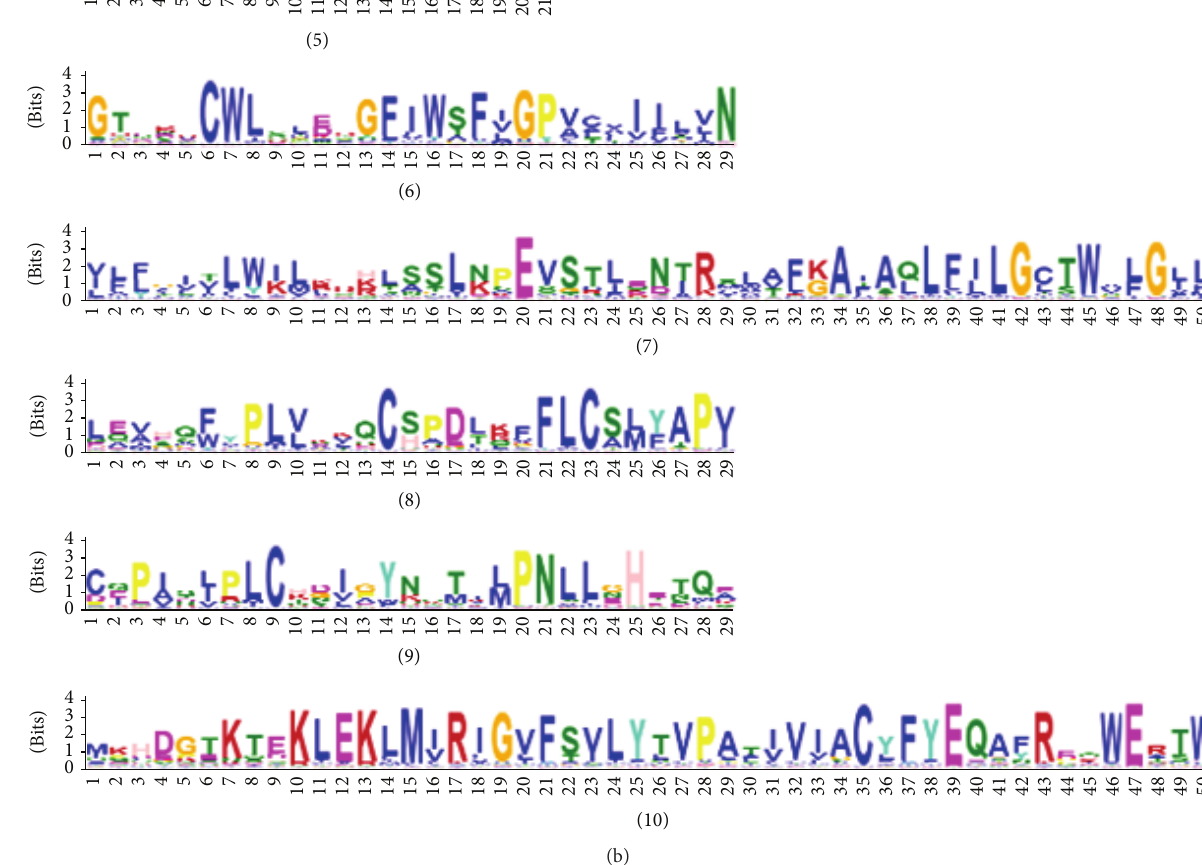
Figure 1: The discovered motifs of human GPCRs from the MEME system (for details see Table 6). (a) MEME run showing combined block diagram for top ten motifs distribution with corresponding sequence ID and E -value ( E -value threshold: 0.01, showing 31 GPCR sequences). (b) The ten motif logos found by